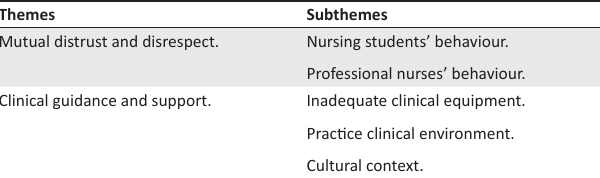
TABLE 1: Nursing students’ perceptions of guidance and support: Themes and